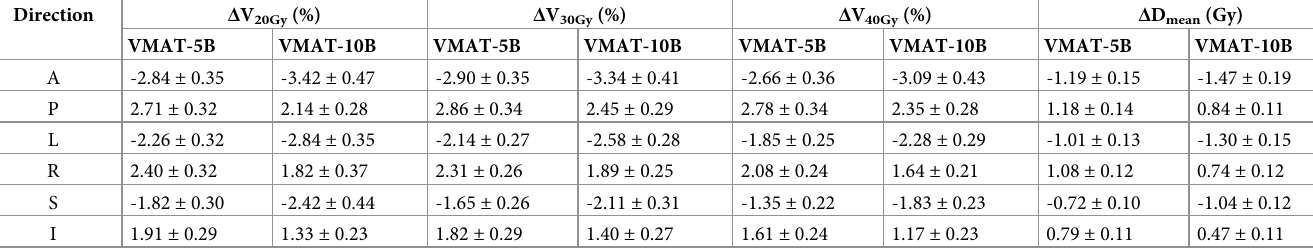
Table 5. Absolute differences in the left lung between the perturbed and the original plans.